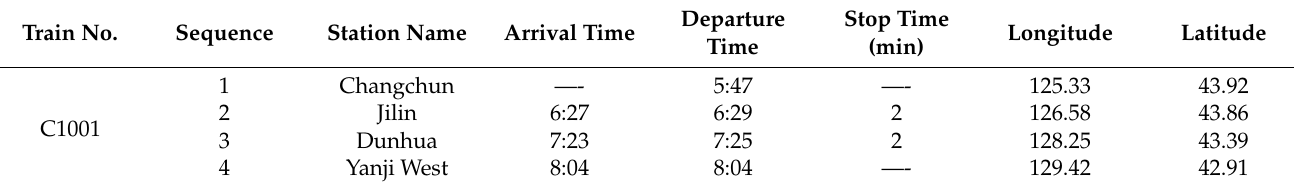
Table 1. An Example of Train Operation Schedule.